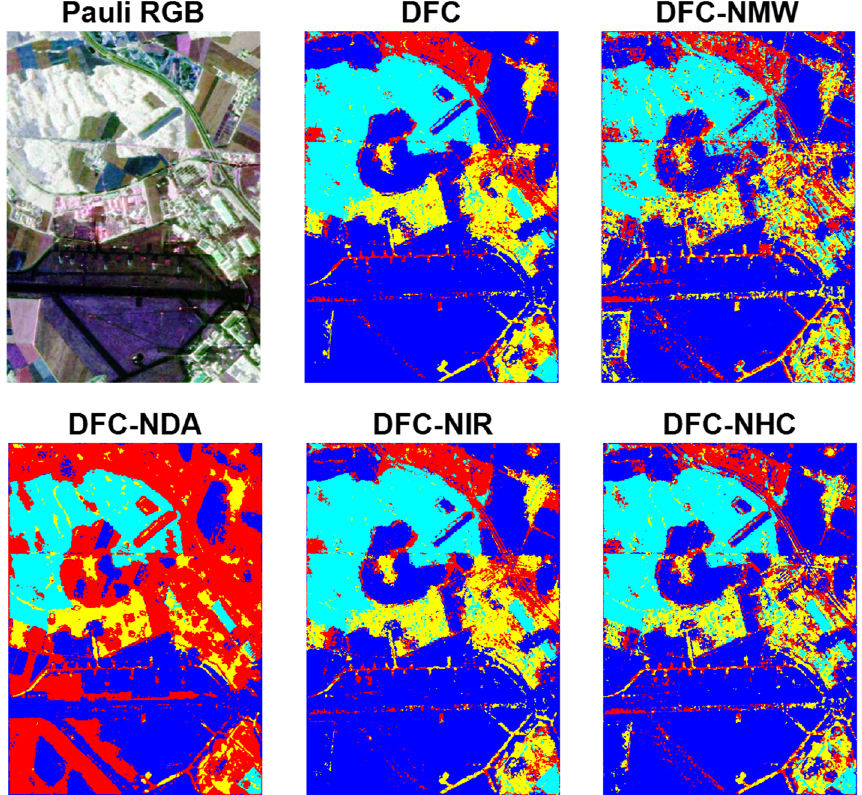
Figure 7. Pauli RGB and the achieved classification maps for Oberpfaffenhofen dataset.